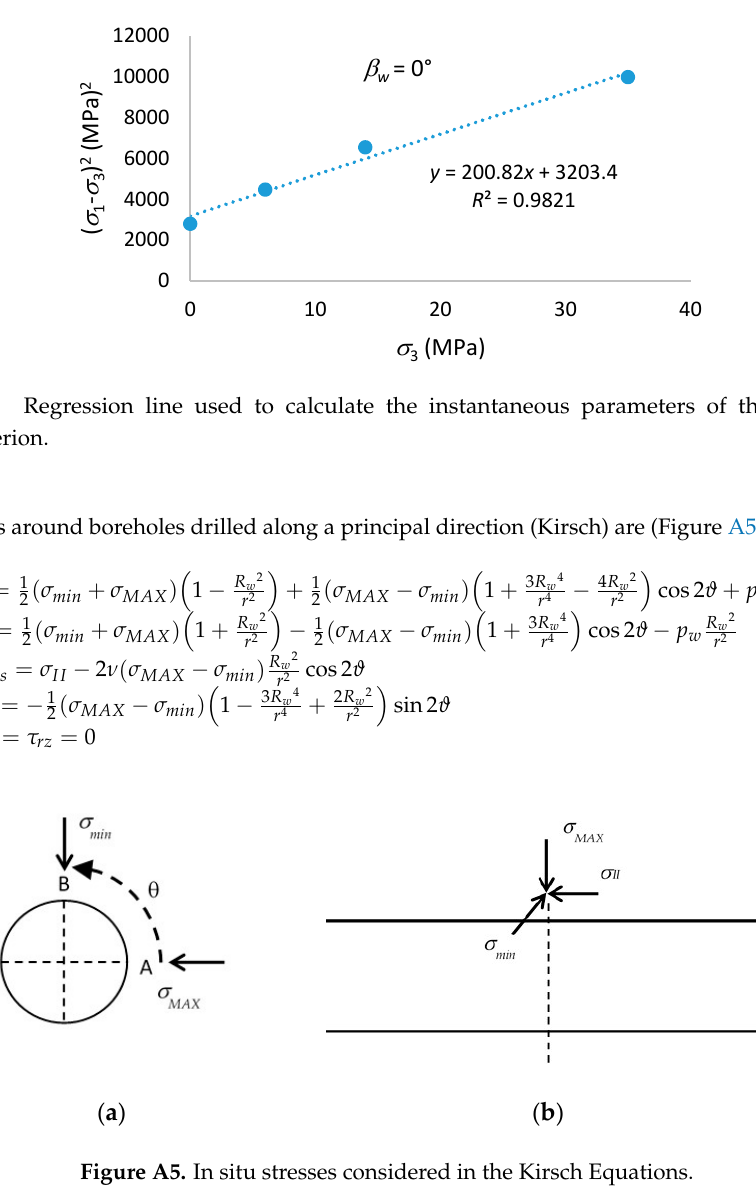
Figure A4. Regression line used to calculate the instantaneous parameters of the Hoek and Brown criterion.